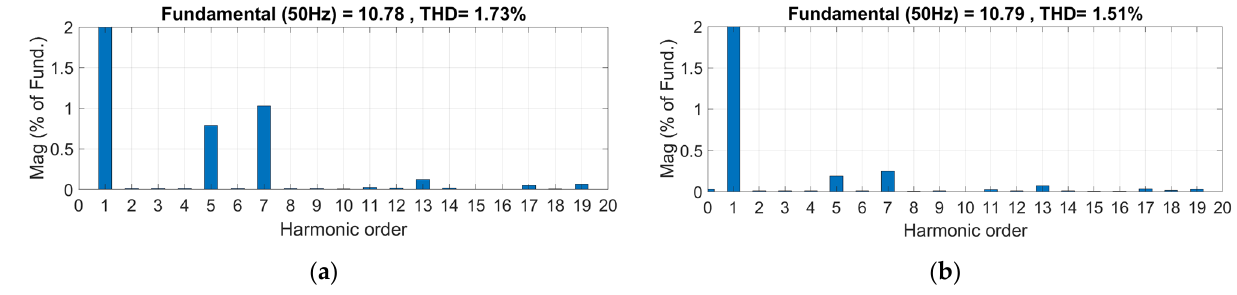
Figure 11. FFT analyzer considering delays for source current ( a ) without APF ( b ) with APF using PQ extraction.